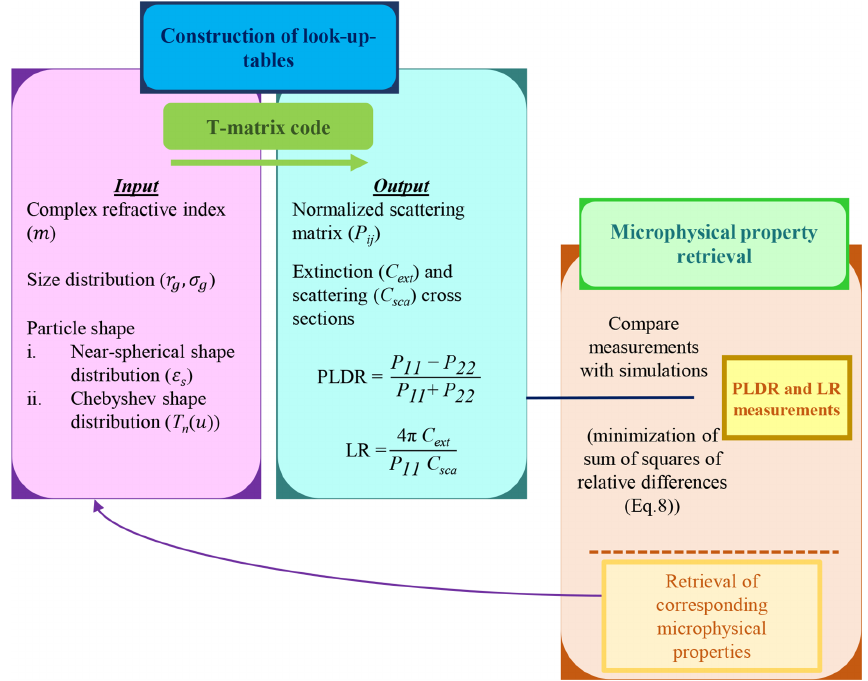
Figure 1. Overview of the methodology followed for the retrieval of the microphysical properties of the stratospheric smoke particles, using the PLDR and LR measurements at 355, 532 and 1064nm: first, we construct appropriate look-up tables of PLDR and LR values for near- spherical and Chebyshev particles using T-matrix calculations, and then we search in the look-up tables for the solution that provides the best fit (minimization of Eq. 8) of the PLDR and LR measurements.